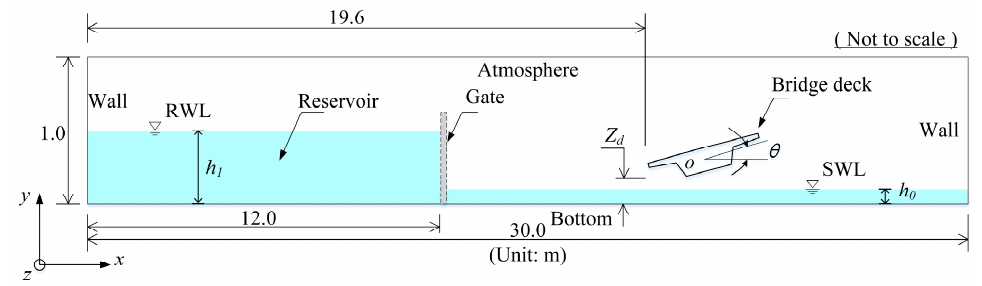
Figure 1. Sketch of the numerical setup. Three different levels of mesh were generated in the present numerical study, i.e., background, main calculation zone, and local refinement zone around the bridge deck, as shown in Figure 2. The meshes in the main calculation zone, with a 5.0 m length and 0.8 m height, were refined to obtain details of the fluid field during wave impact. The cell lengths were 0.05 m and 0.00625 m for the background and the local refinement zone, respectively. A mesh sensitivity analysis was carried out with four different mesh sizes of the main calculation zone. The cell length, total mesh number, and calculation time (using a computer with a double Inter Xeon Gold 5218R processor (2.1 GHz and 40 M cache) CPU and 128 G internal storage) for four different mesh sizes are listed in Table 2. Figure 3 shows the maximum horizontal force ( F x-max ) and vertical forces ( F y-max ) acting on the bridge deck during the dam break wave impact. It can be seen that the maximum tsunami-induced forces oscillated with a mesh size change from 0.05 m to 0.0125 m. However, further mesh refinement did not significantly improve the numerical results of the forces. A mesh size of 0.0125 m in the main calculation zone was adopted in the following analysis to achieve a balance between the accuracy and computational consumption.